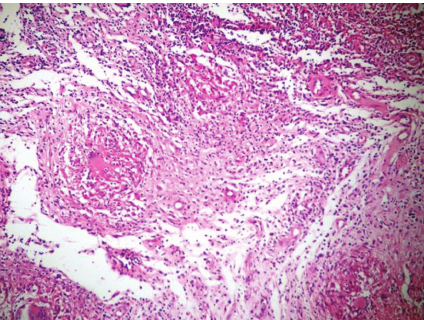
Figure 6: Hematoxylin and Eosin stained biopsy specimen showing typical areas of caseating necrosis surrounded by epithelioid cells and Langerhan’s giant